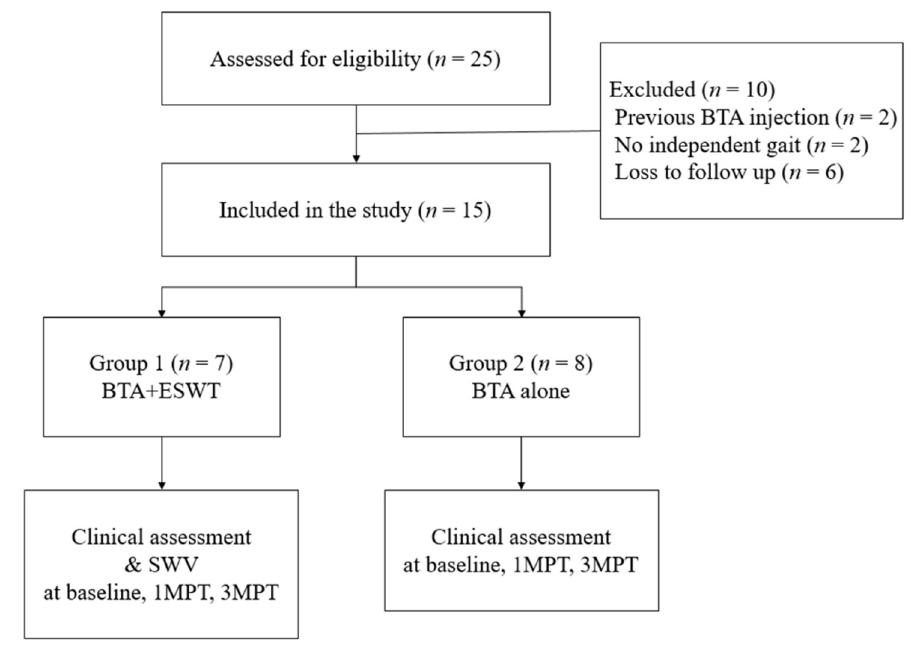
Figure 3. The flowchart of the study.